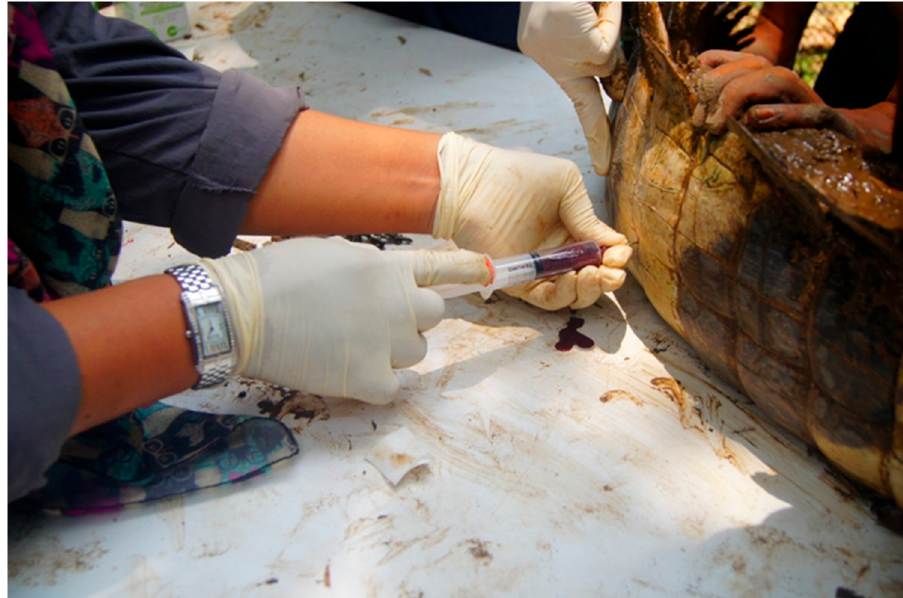
Figure 2. Bleeding procedure for the false gharial, where blood was drawn from the lateral caudal vein using an 18G hypodermic needle. vein using an 18G hypodermic